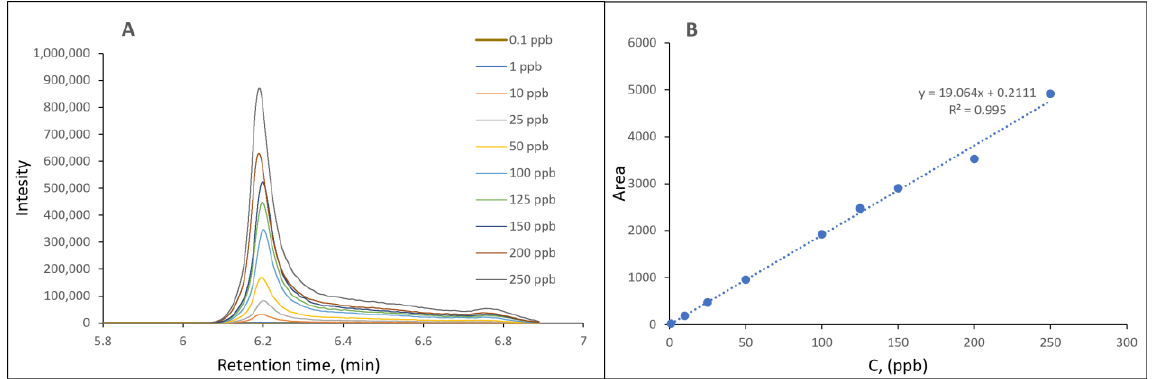
Figure 8. ( A ) Coumaphos LC-MS/MS retention time versus intensity graph. ( B ) Coumaphos calibration